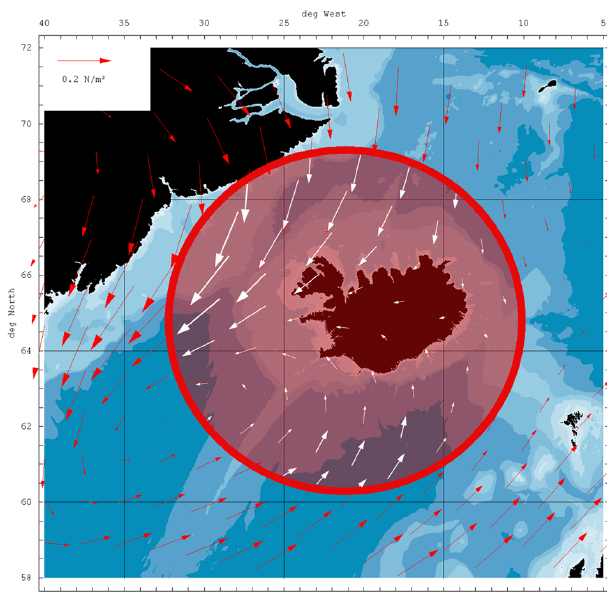
Fig. 14. Bathymetry and mean surface wind stress averaged over the period 1992 to 2006. In the frame of the various sensitivity ex- periments different forcing terms were switched off within the red encircled